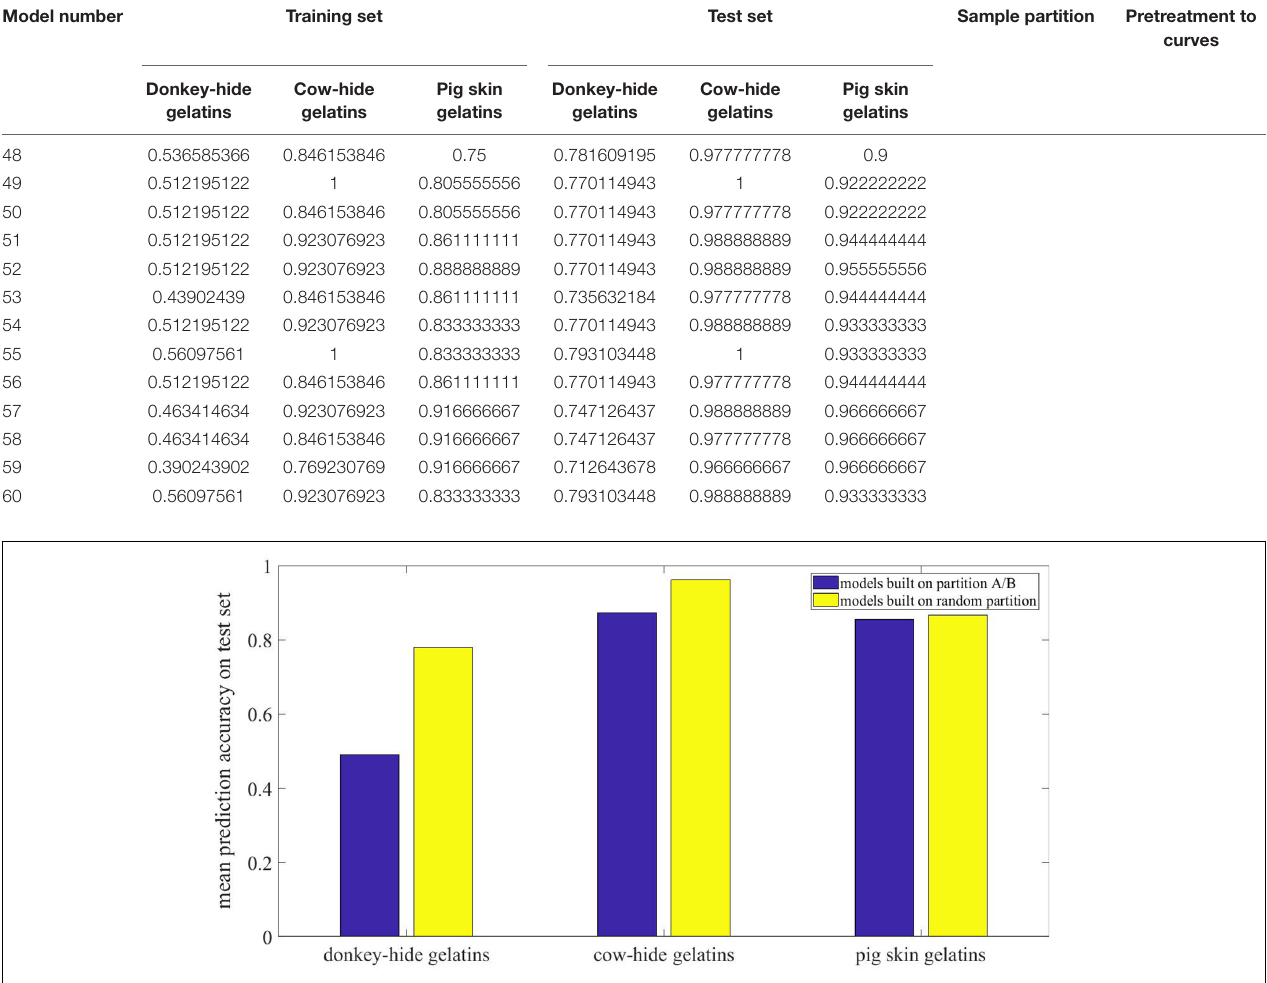
FIGURE 5 | Probability of being predicted right when sample belongs to test set. An ascending sort is given before depicting this figure according to the probability of being predicted right in multiple models for individual sample. The sample number herein is not the coding or order used in tests but the rank according to probability of being predicted